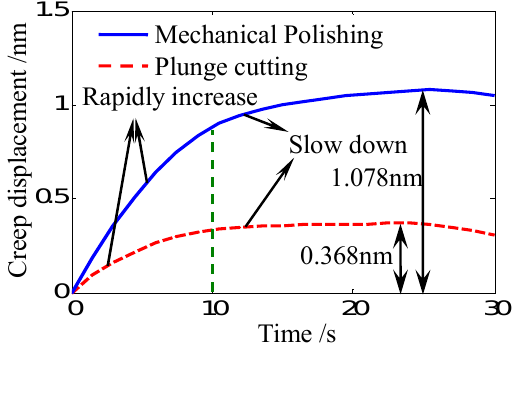
Figure 4. Creep displacement curves of the Zr-based bulk metallic glass during the dwell time under different sample preparation